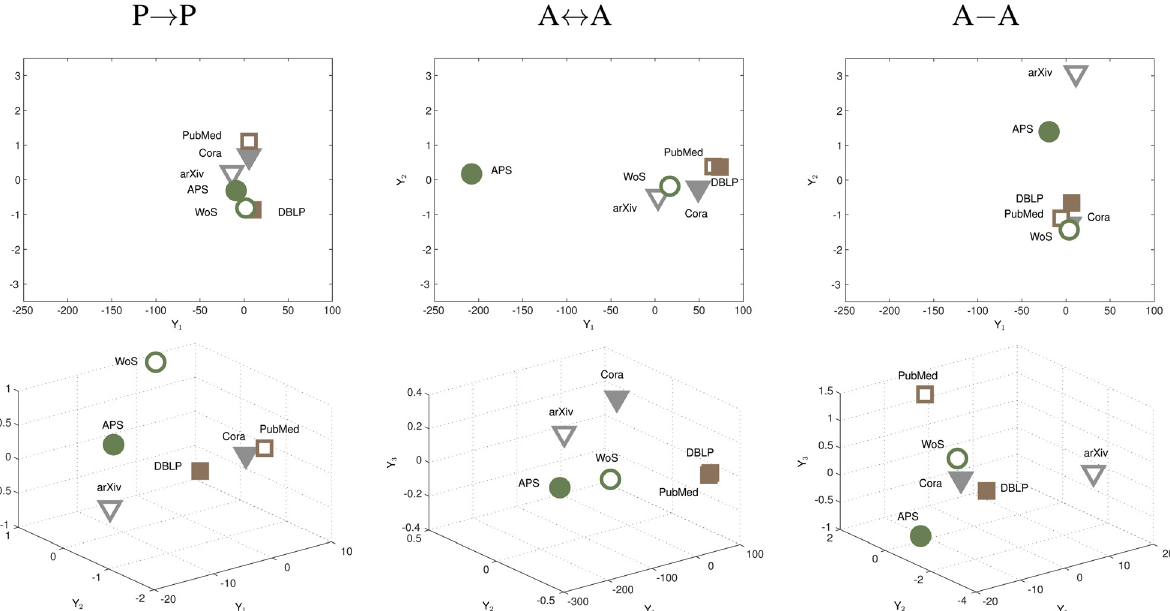
Fig 2. Multidimensional scaling (MDS) analysis. Embedding of points in 2D (top row) and 3D space (bottom row) obtained via MDS. Each point represents one database as indicated. Distance between any pair of points is representative of the average difference of network measure values for the corresponding database pair, and in adequate ratio with distances between other points in that plot.